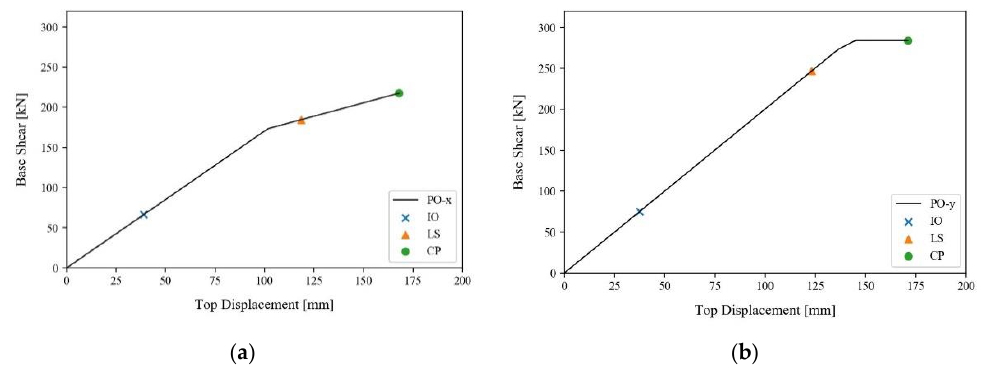
Figure 9. Push Over curves: results for ( a ) X- and ( b ) Y- directions.